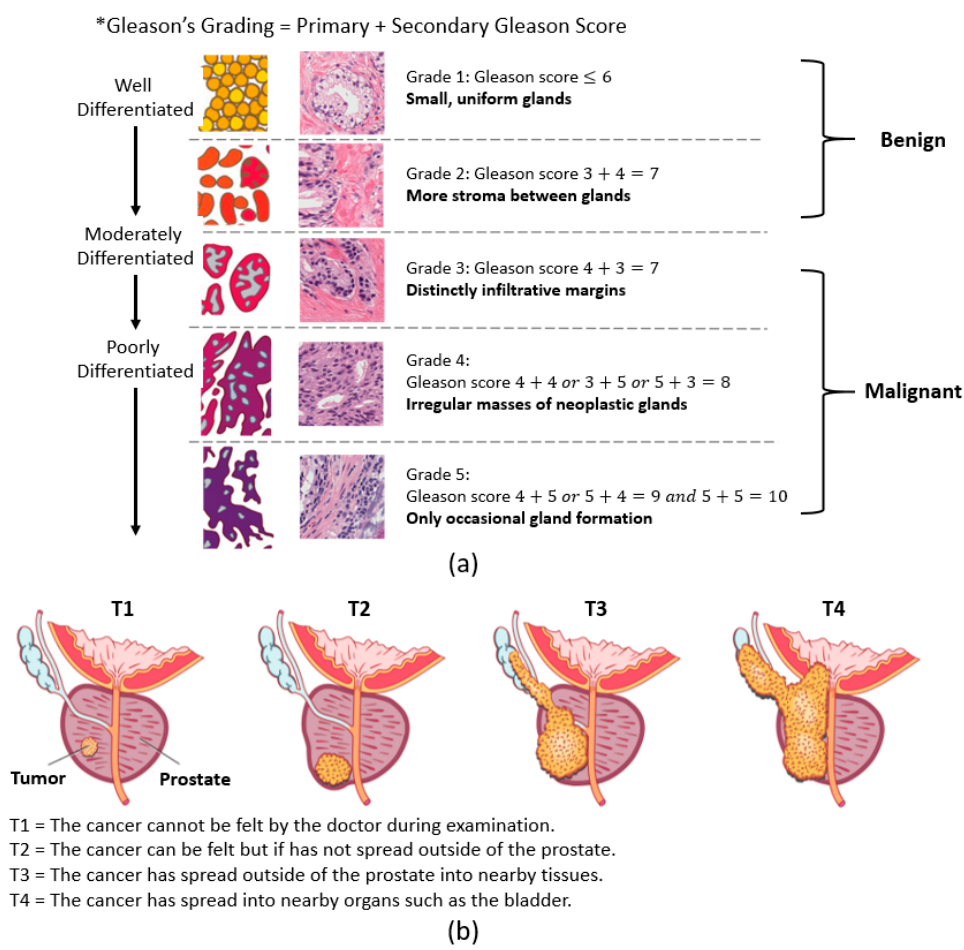
Figure 1. The grading and staging of prostate cancer. ( a ) The Gleason grading system. ( b ) The tumor staging system (Source: https://sunshinecoasturology.com.au/useful-info/urological-conditions/what-is-prostate-cancer/ accessed on 2 March 2021).